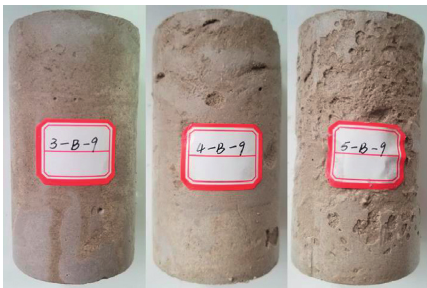
Figure 8: Saturated specimens with different water-to-cement ratios under the same number of dry-wet cycles.